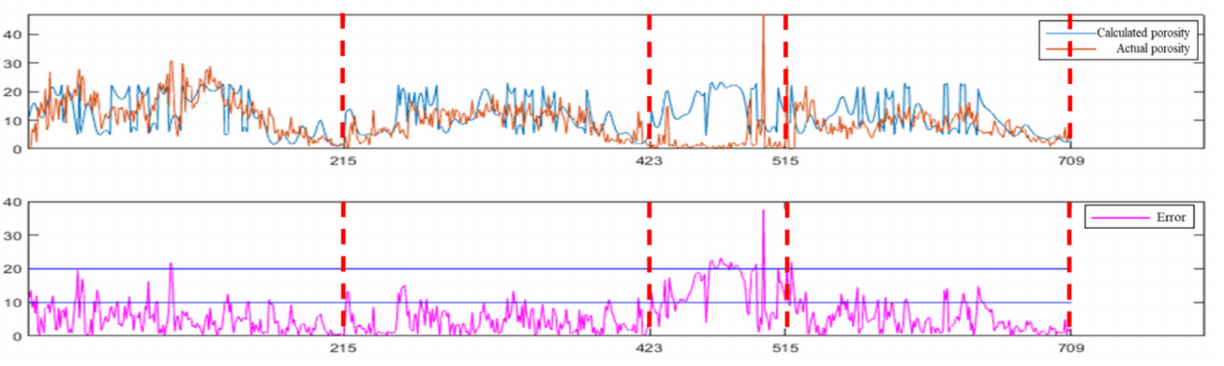
Figure 12. Comparison of actual porosity from the four new wells and porosity calculated by LSTM